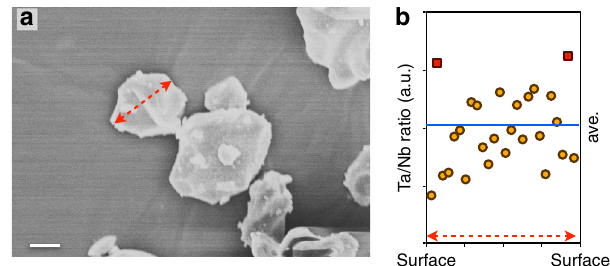
Fig. 5 Ta-doped LNMO and the Ta distribution in the particle. SEM image (scale bar, 2 μ m) of the as-prepared Li 1.3 Nb 0.285 Ta 0.015 Mn 0.4 O 2 ( a ), and